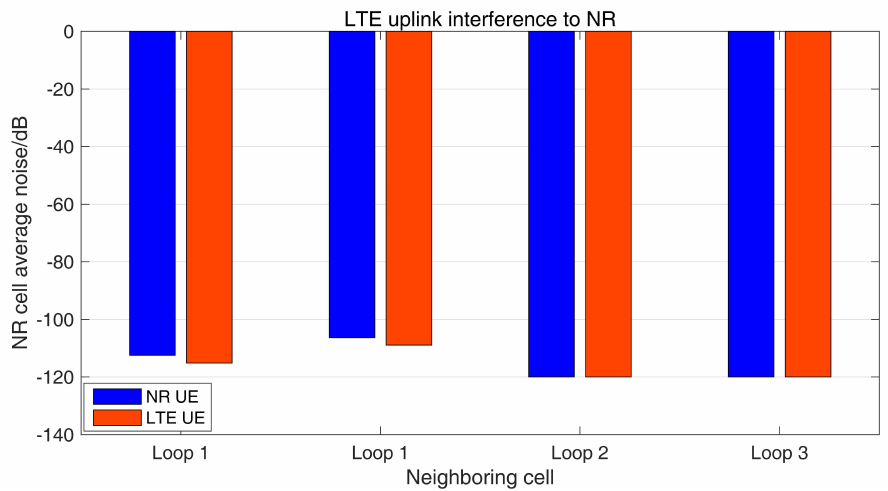
Figure 17. LTE terminal to NR uplink interference test